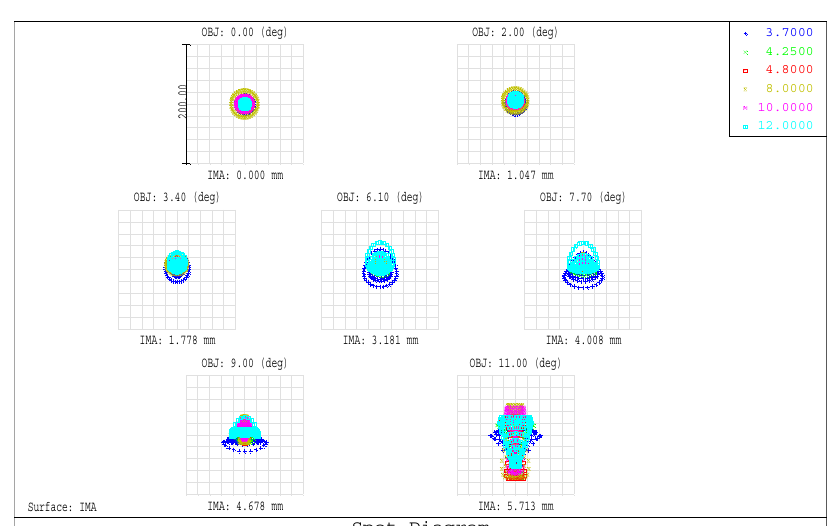
Figure 3. Spot diagram.